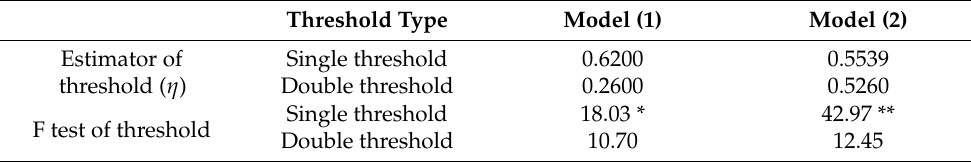
Table 2. Threshold model specification test